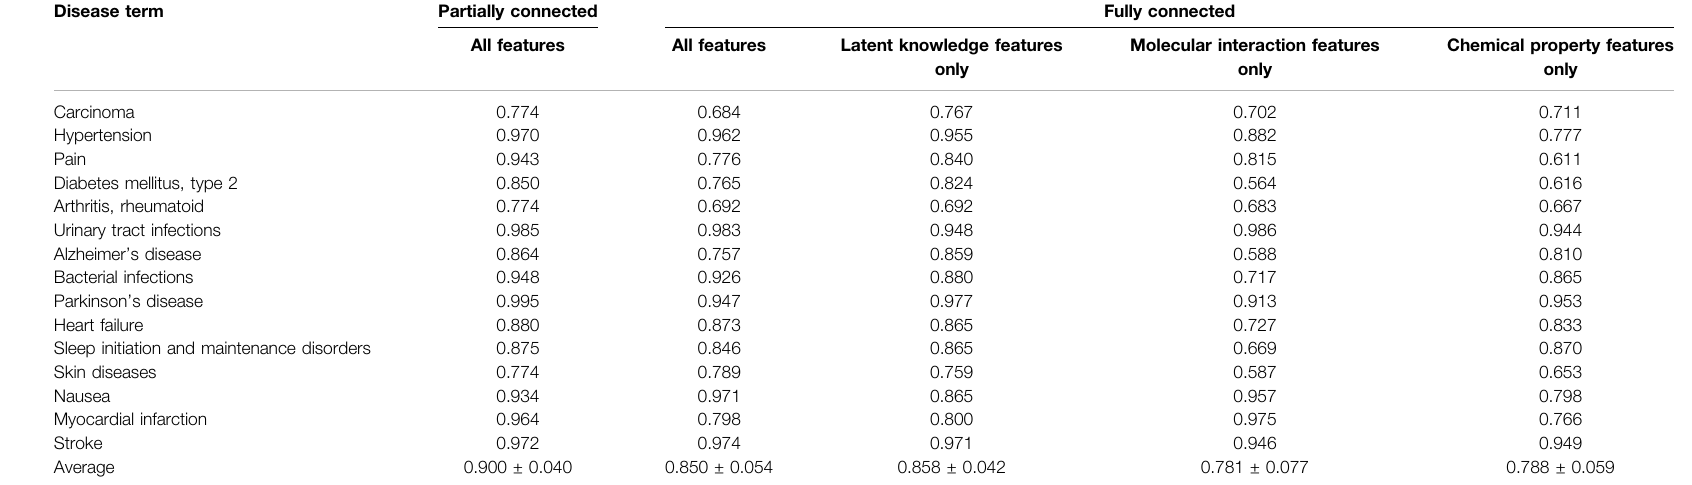
TABLE 1 | AUROC values of the fi ve different cases of the trained models in predicting the medicinal uses of drugs for 15 diseases. Disease